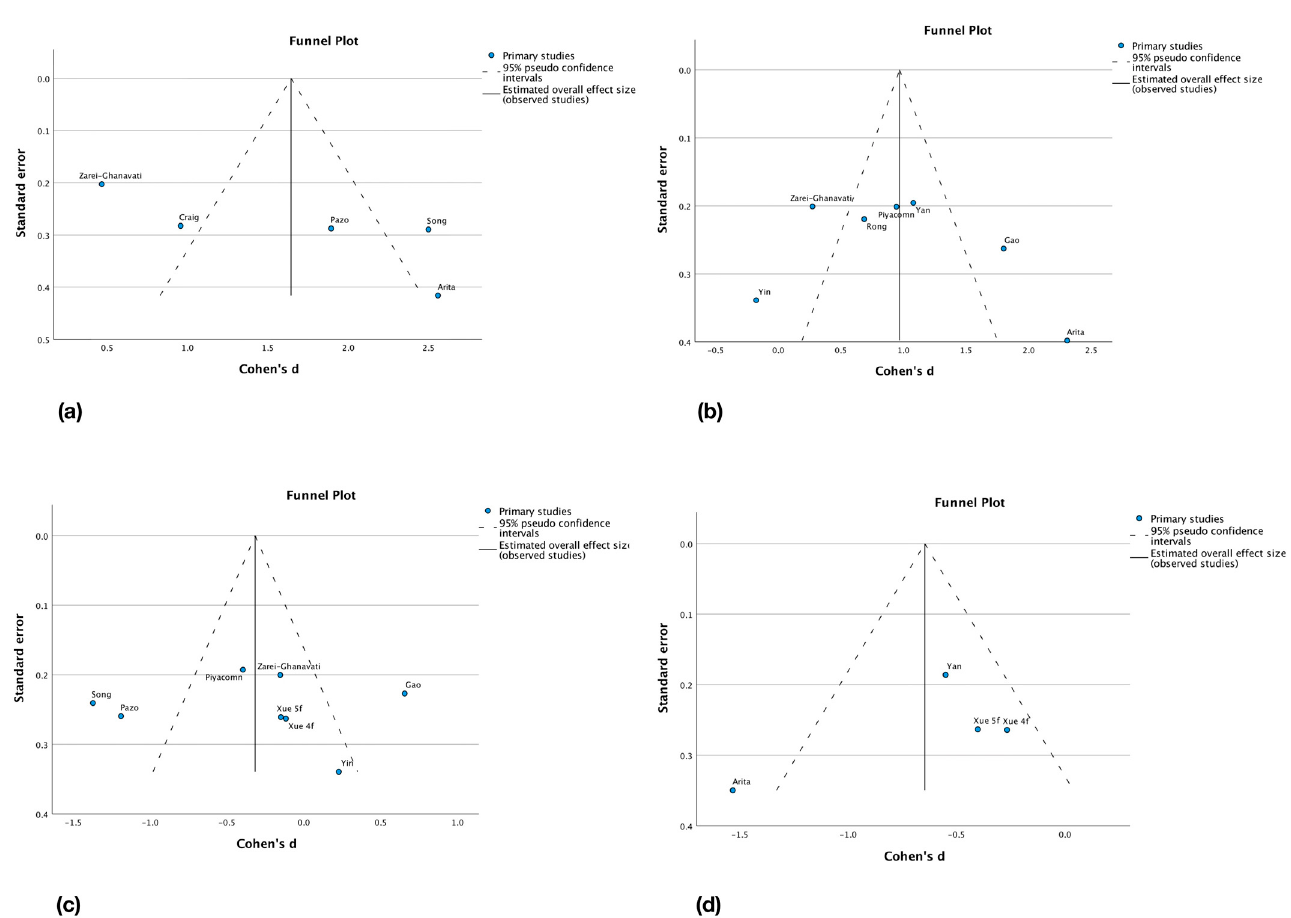
Figure 4. Reporting bias assessment, change from baseline between groups, funnel plots. ( a ) NIBUT; ( b ) TBUT; ( c ) OSDI; ( d ) SPEED [12,29–38].